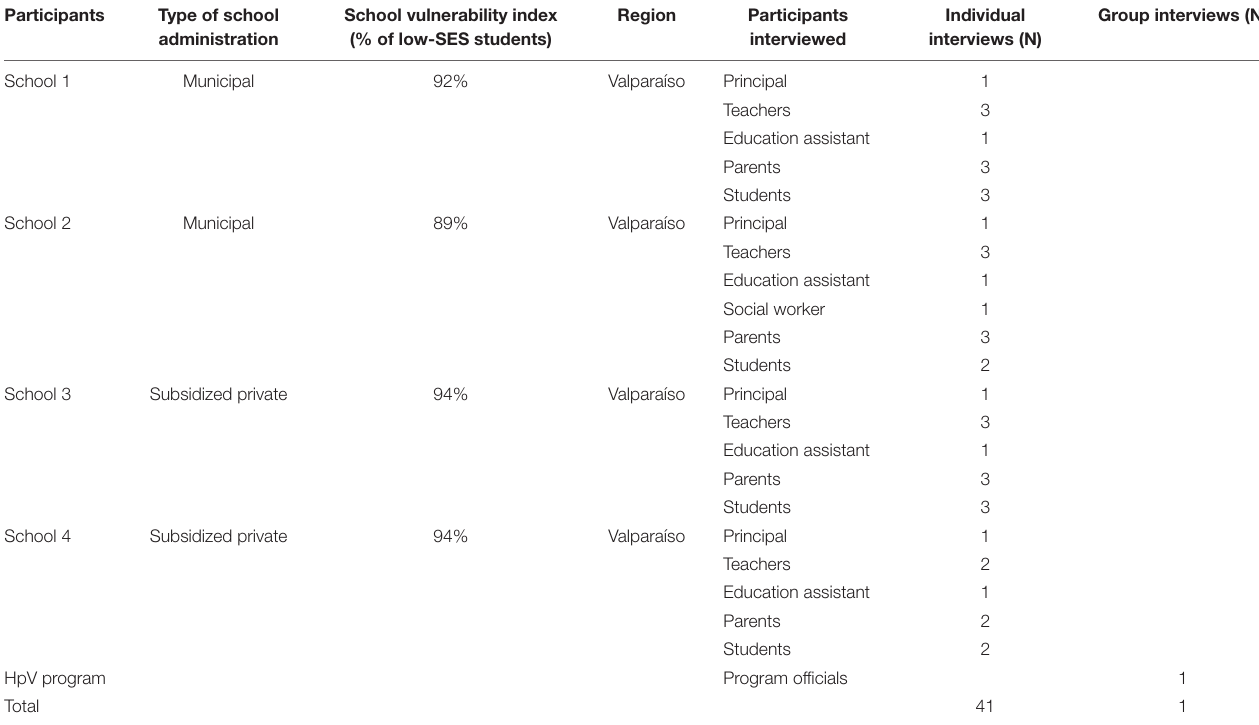
TABLE 1 | Participants and data production